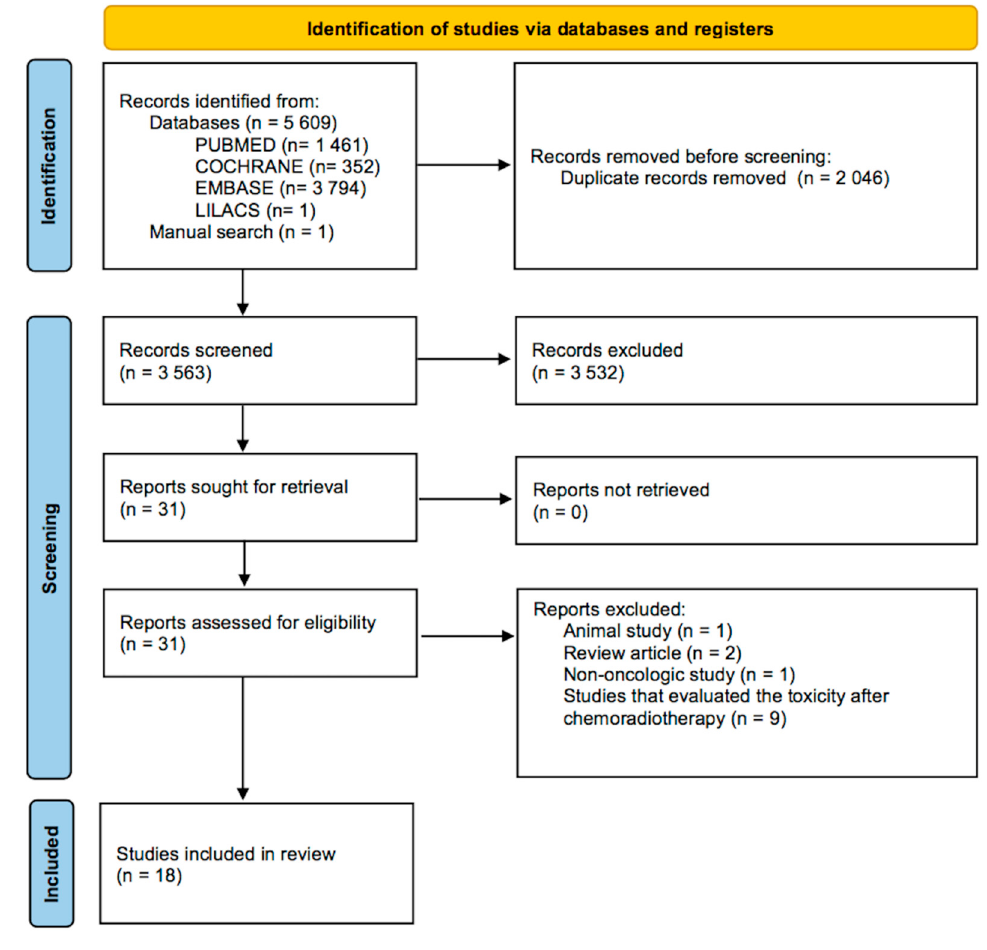
Figure 5. PRISMA’s selection flow diagram.